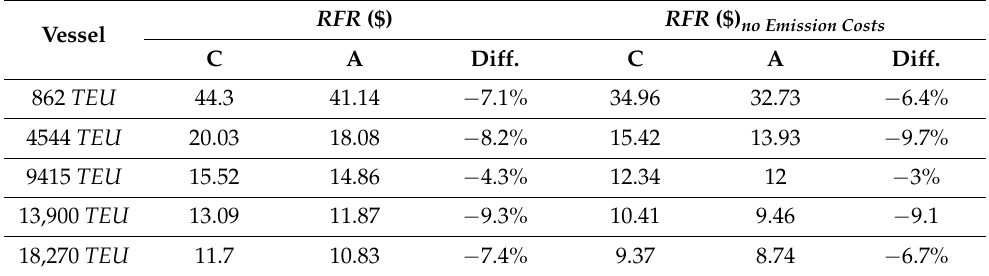
Table 3. RFR of conventional and autonomous ships for year 2040, with and without emission costs.